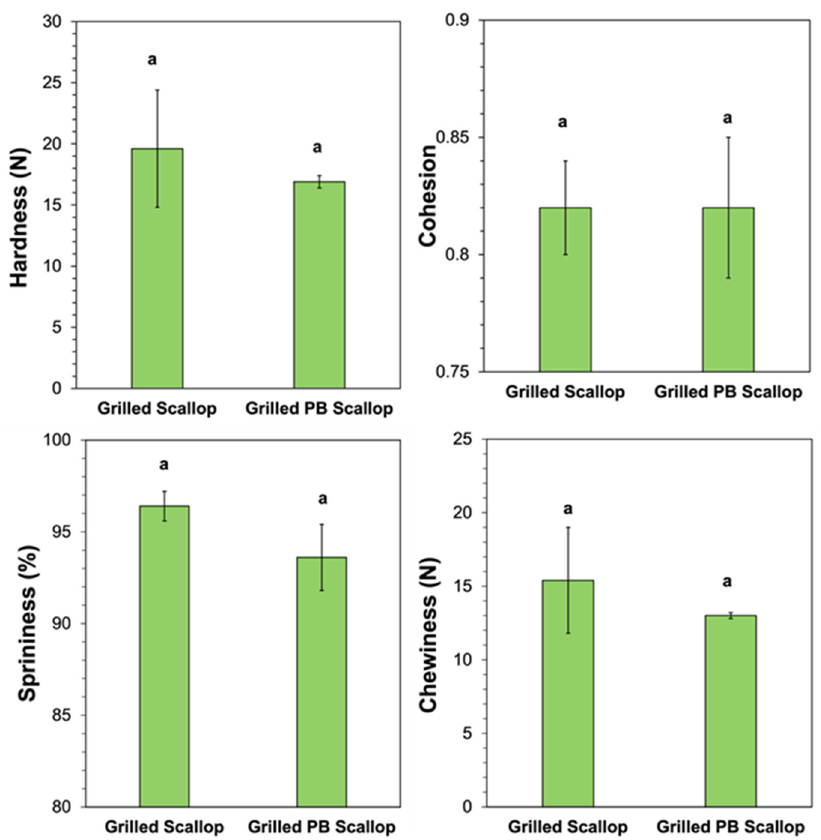
Figure 8. Textual profile analysis of scallop and scallop analog. The scallop analogs contained 10% pea protein, 0.5% pectin, and 2% transglutaminase. Error bars represent the standard errors (n = 3), and similar letters mean no statistical difference between treatments ( p ≤ 0.05).